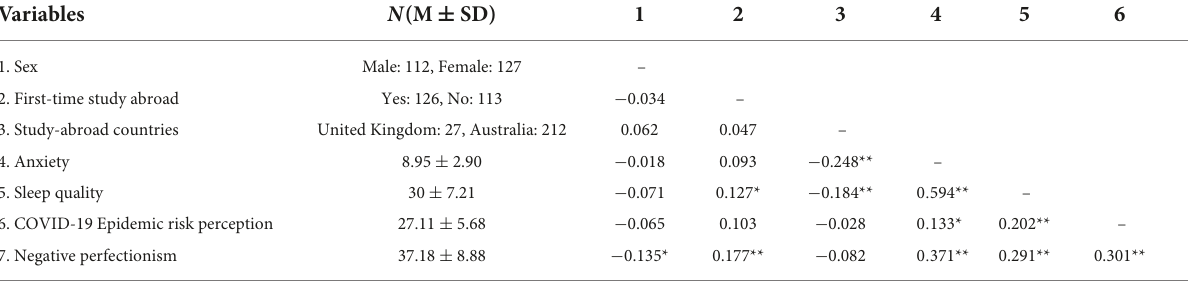
TABLE 1 Correlation analysis of perfectionism, anxiety, epidemic risk perception and sleep quality.